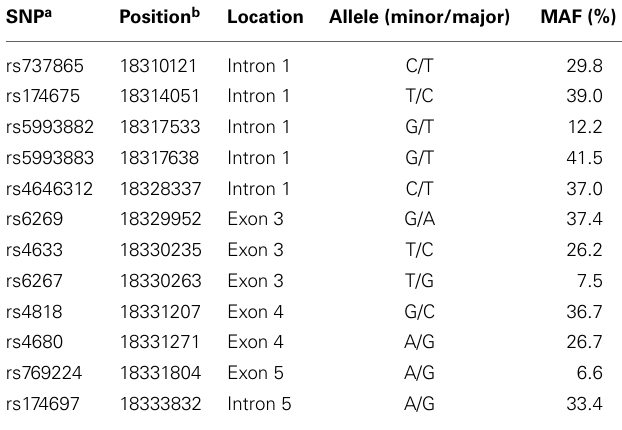
Table 2 | Characteristics of the genotyped COMT